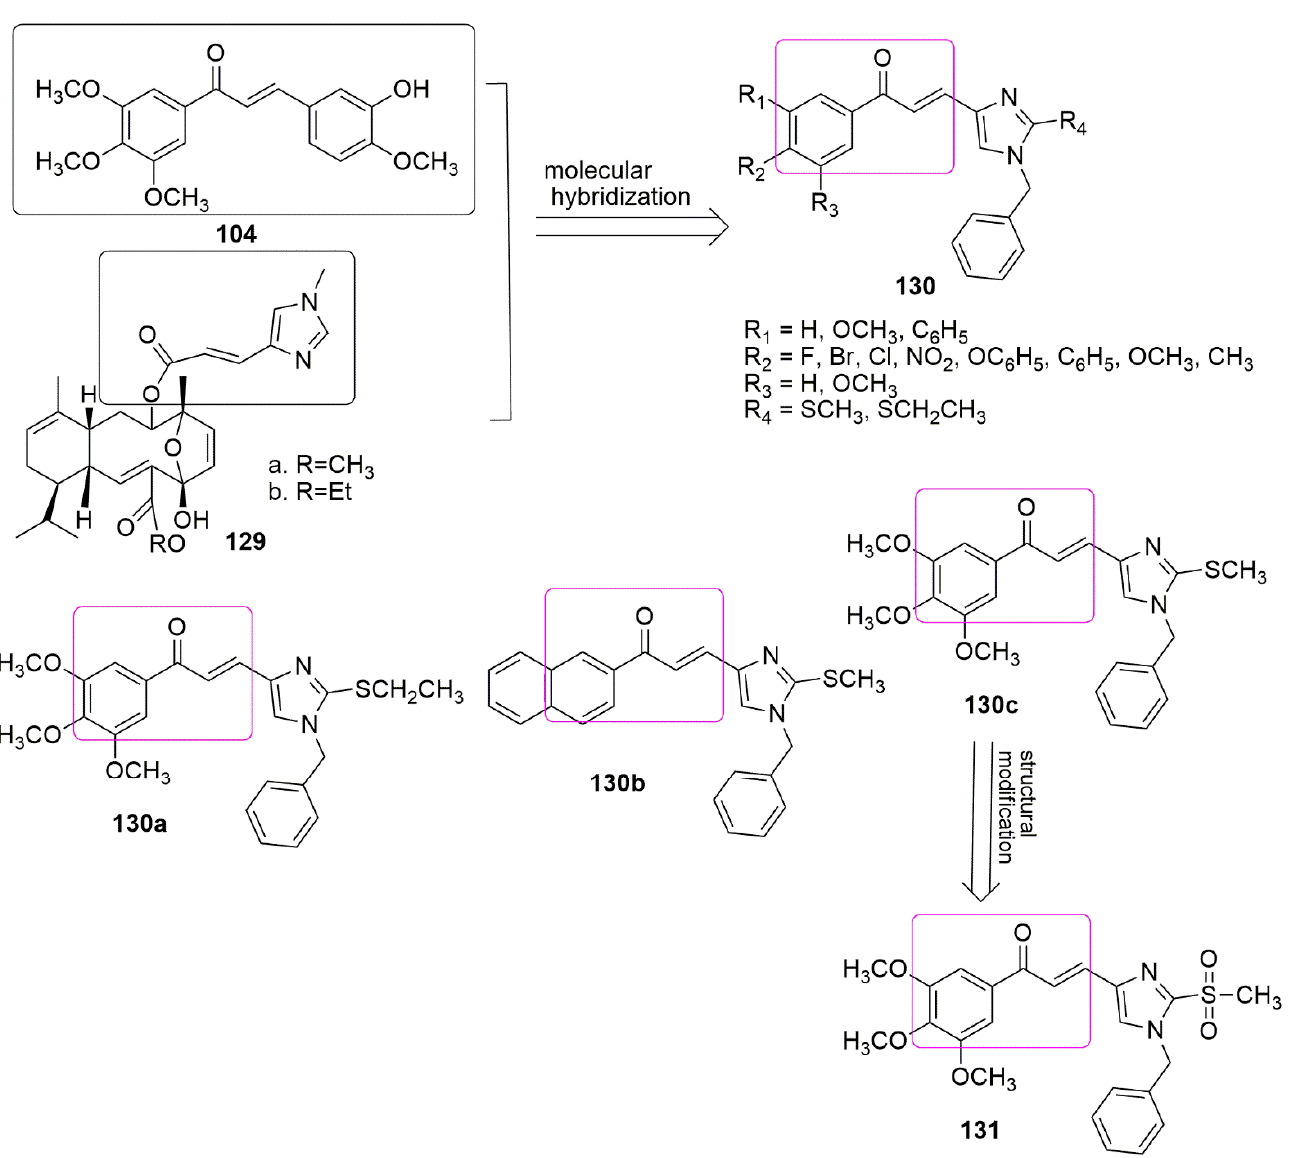
Figure 36. Chemical structures of imidazole–chalcone conjugates.